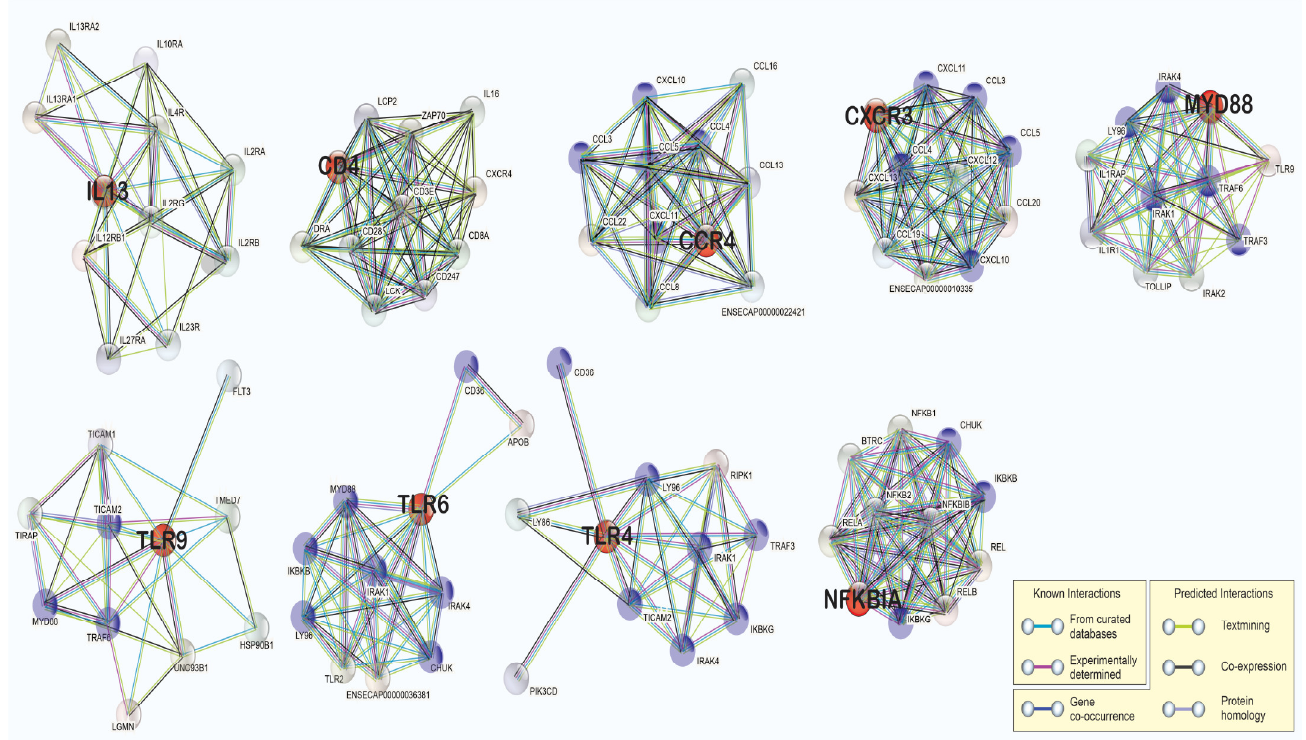
Figure 4. Protein network of the differentially expressed genes (red), showing the main proteins with which, they interact. There were proteins that were present more than once (blue) among these groups of networks. The networks were obtained from the STRING database based on the functional enrichment analysis of the protein–protein interaction networks.